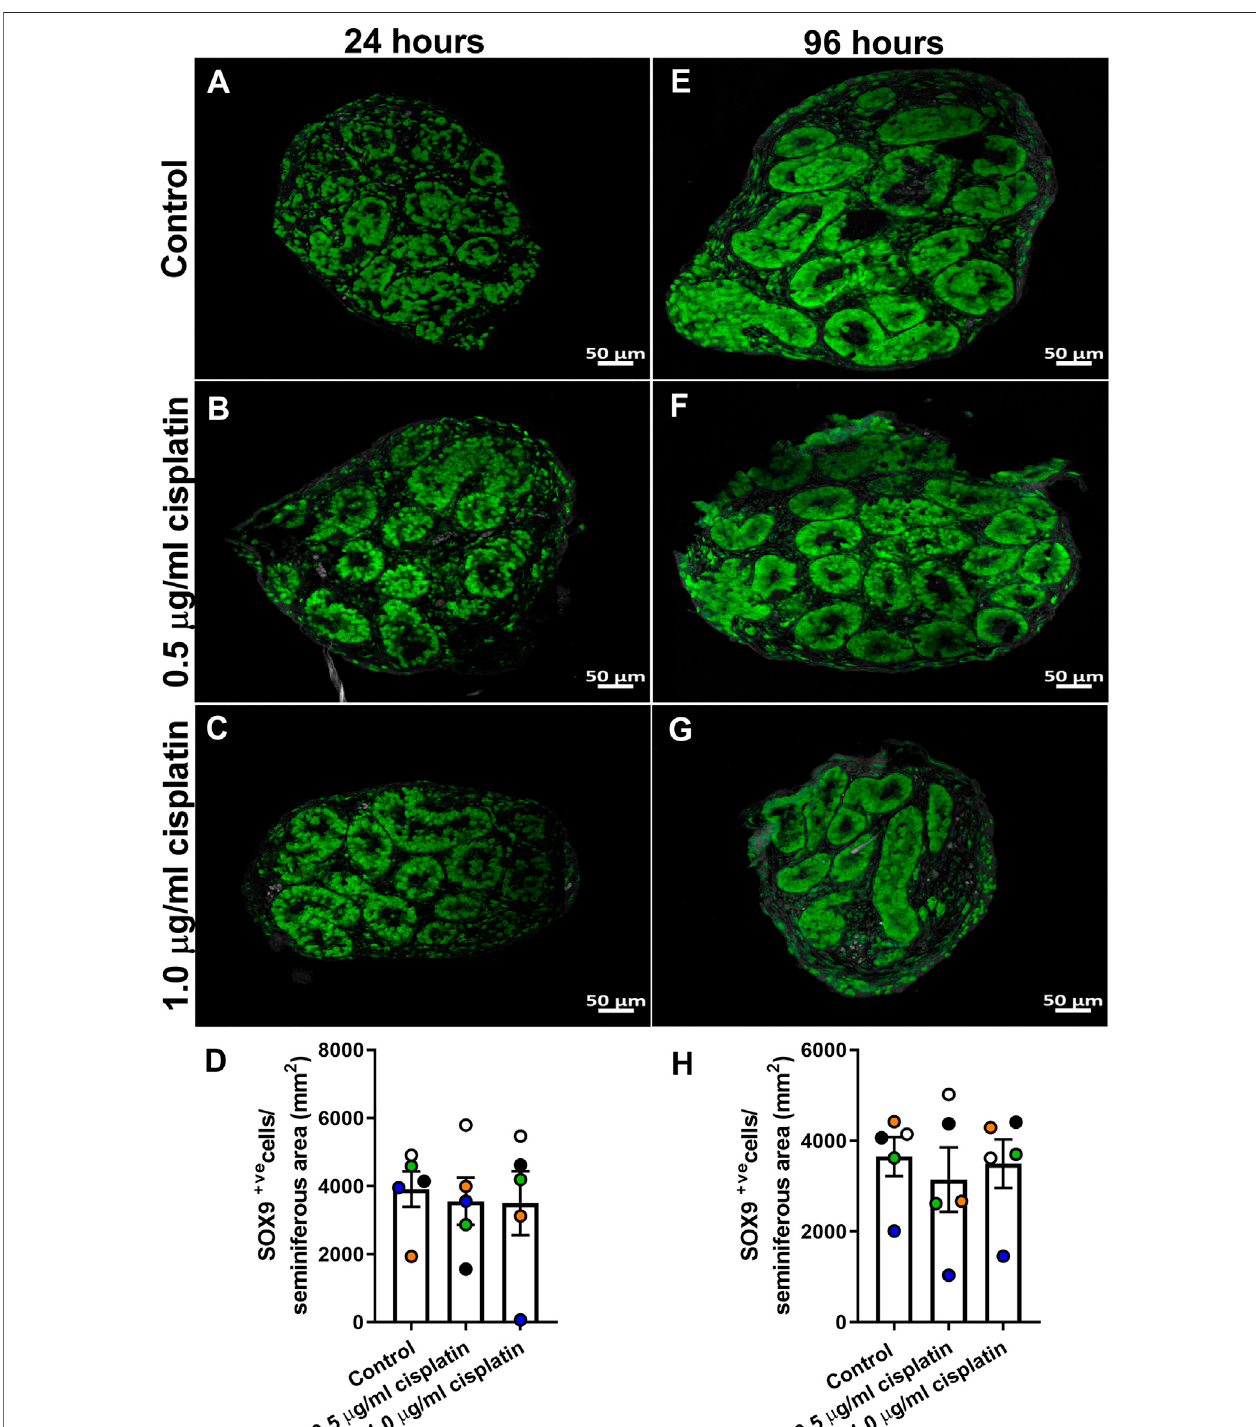
FIGURE 1 | Acute effects of exposure to cisplatin on Sertoli cell numbers in the human fetal testicular tissues. SOX9+ (green) protein expression in the human fetal testicular tissues 24 h (A – C) and 96 h (E – G) following exposure to vehicle control or cisplatin (0.5 and 1.0 μ g/ml). Scale bars represent 50 μ m. Quanti fi cation of Sertoli cell(SOX +ve )numberspercordarea(mm 2 )inthehumanfetaltesticulartissues24 h (D) and96 h (H) followingexposuretovehiclecontrolorcisplatin(0.5and1.0 μ g/ml). Sertoli cell numbers were unaffected at either 24or 96 h post-exposure to0.5 μ g/ml and 1.0 μ g/mlcisplatin. Dataanalysed using two-way ANOVA. Values shown are means ± SEM and each set of coloured data point represents an individual fetus ( n = 5).